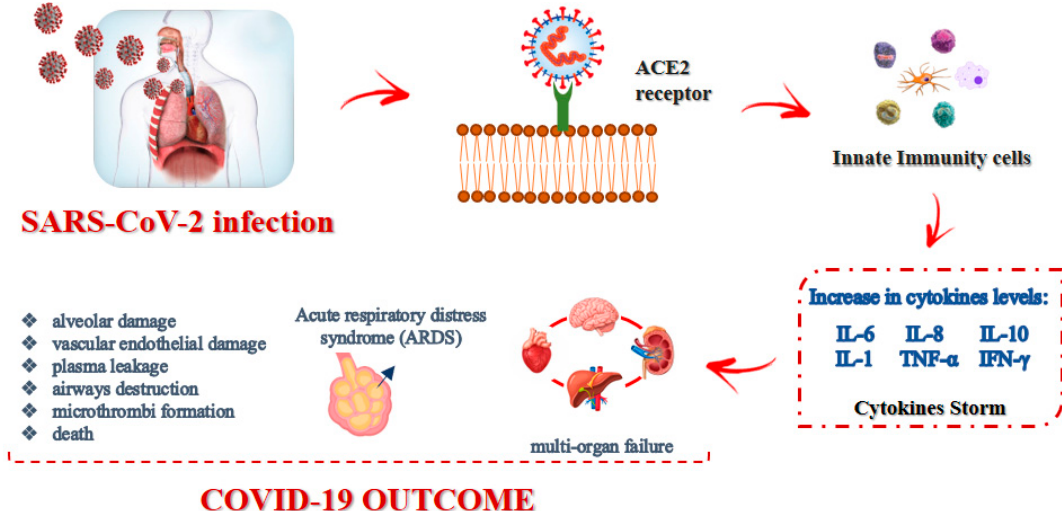
Figure 1. SARS-CoV-2 infection modality and effects.